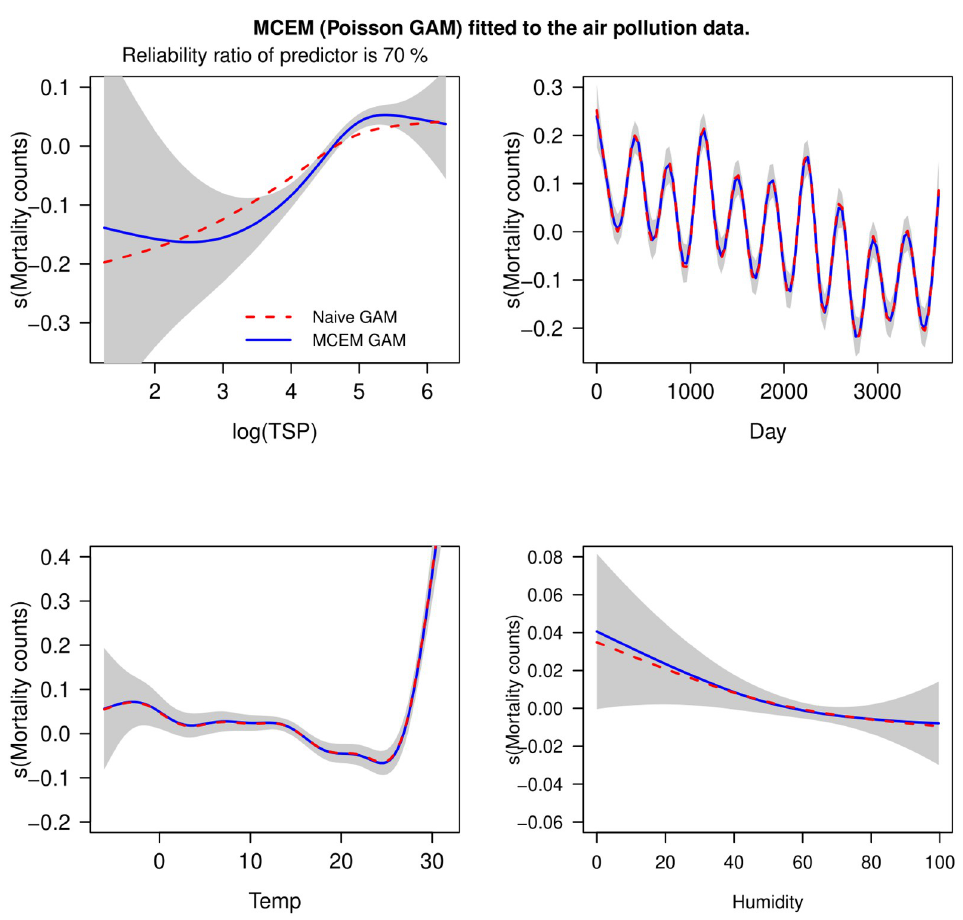
Fig 3. Poisson GAMs using MCEM (solid line) and a na ï ve model (dashed line) fitted to the air pollution data recorded in Milan, Italy 1980–1989. We also give 95% confidence bands. The response variable is total mortality counts. We plot the additive terms for (a) total suspended particles (log(TSP)), (b) day, (c) temperature, and (d) humidity. The log(TSP) covariate is assumed to have a reliability ratio of 70%.